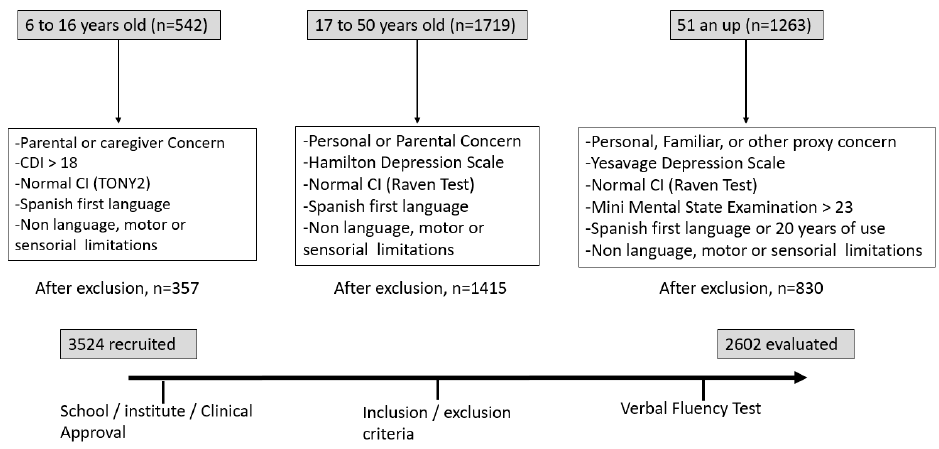
Figure 1. Flow chart of participant recruitment and the final study sample obtained after applying the inclusion/exclusion criteria that involved different tests and psychological evaluation.